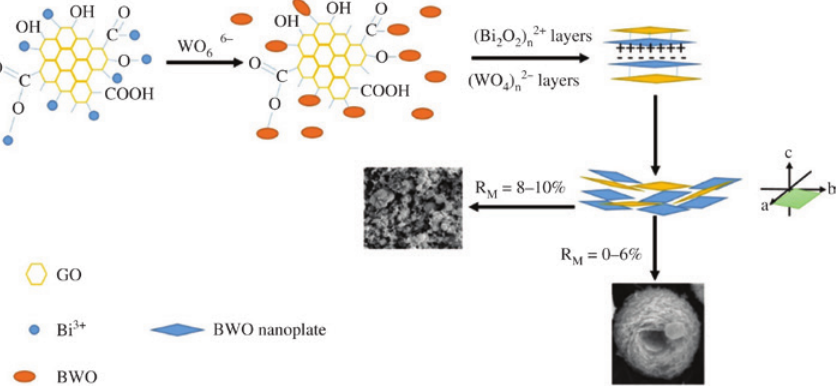
Scheme 1: Formation mechanism of the rGO-BWO